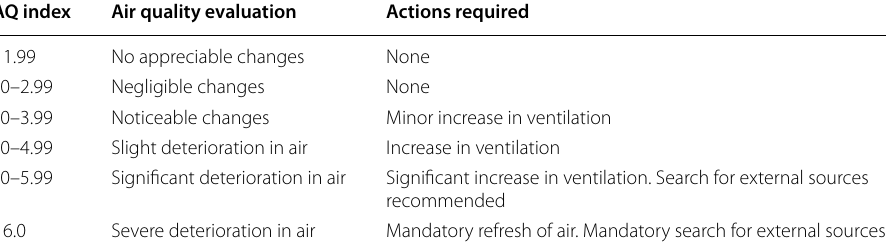
Table 2 IAQ index